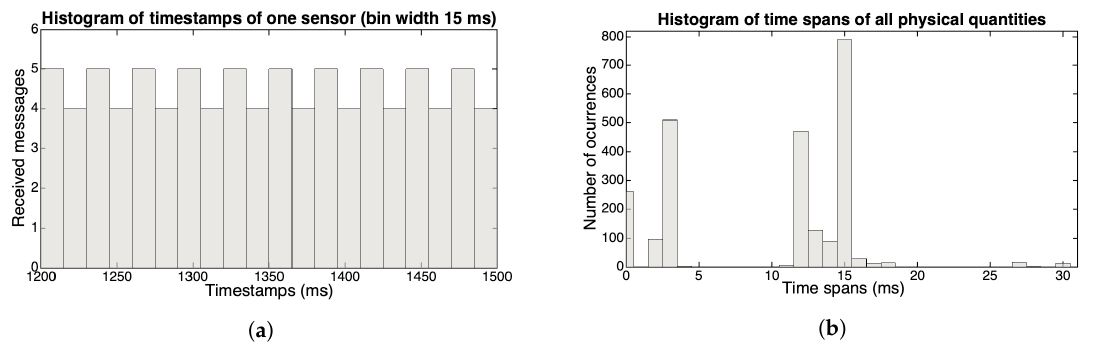
Figure 1. Time spans between IMU incoming messages. ( a ) Histogram of timestamps of one sensor with a bin width of 15 ms; ( b ) Histogram of time spans between subsequent messages of all physical quantities in a particular take.